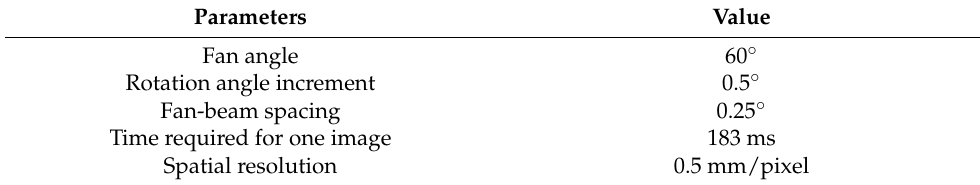
Table 4. Parameters of the fan-beam CT simulator.